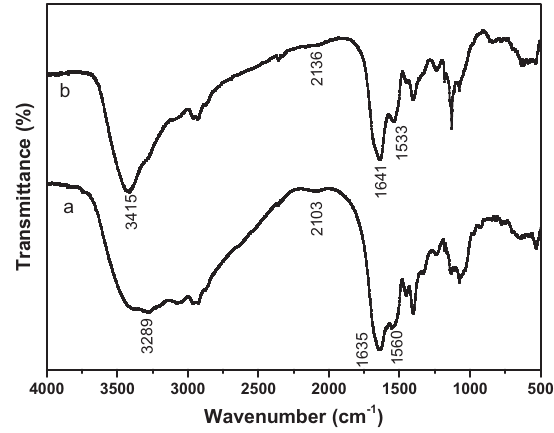
Figure 3: IR spectra of B. subtilis cells before ( a ) and after ( b ) adsorption for 100 µg/L Hg 2 + solution.